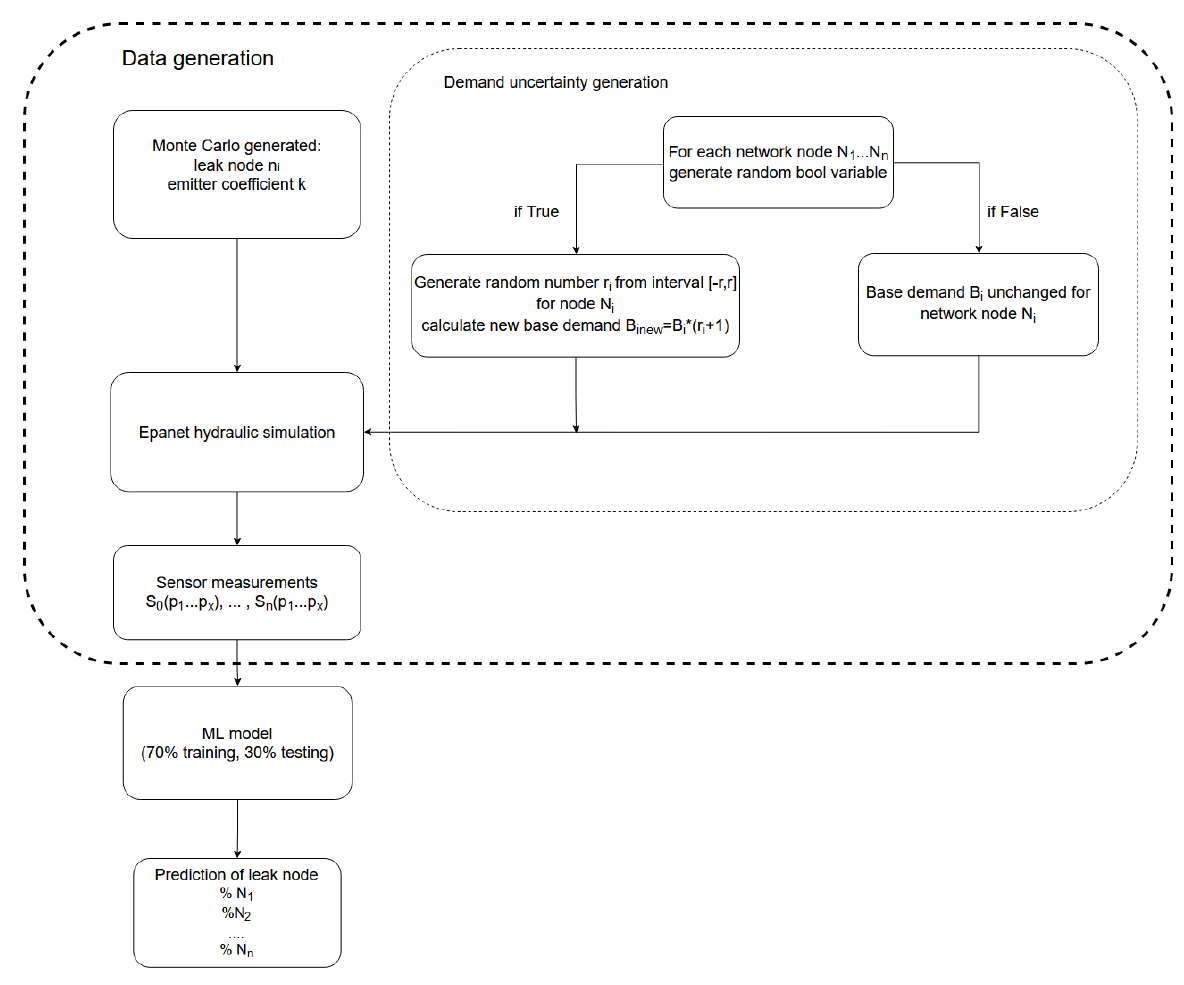
Figure 4. Flowchart of data generation and the machine learning algorithm used for the prediction of leak